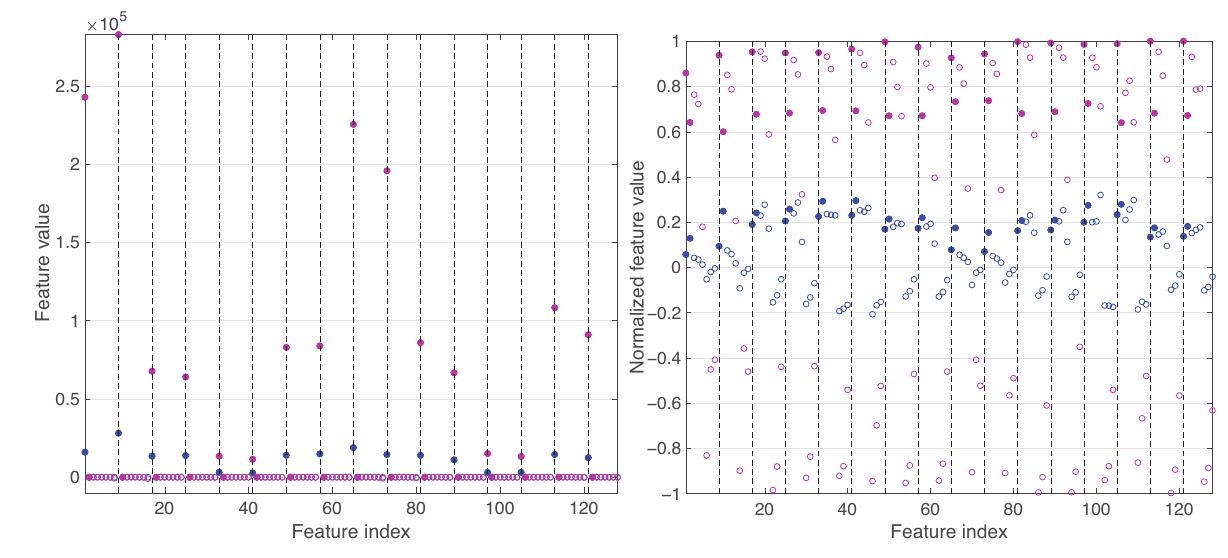
Figure 6. Two unfolded samples in dataset #1 (ethanol compound in blue and ethylene compound in magenta). Initial feature values, i.e., 8 features per 16 sensors ( left ) and min-max normalized values ( right ). The steady-state features are highlighted by solid circles.